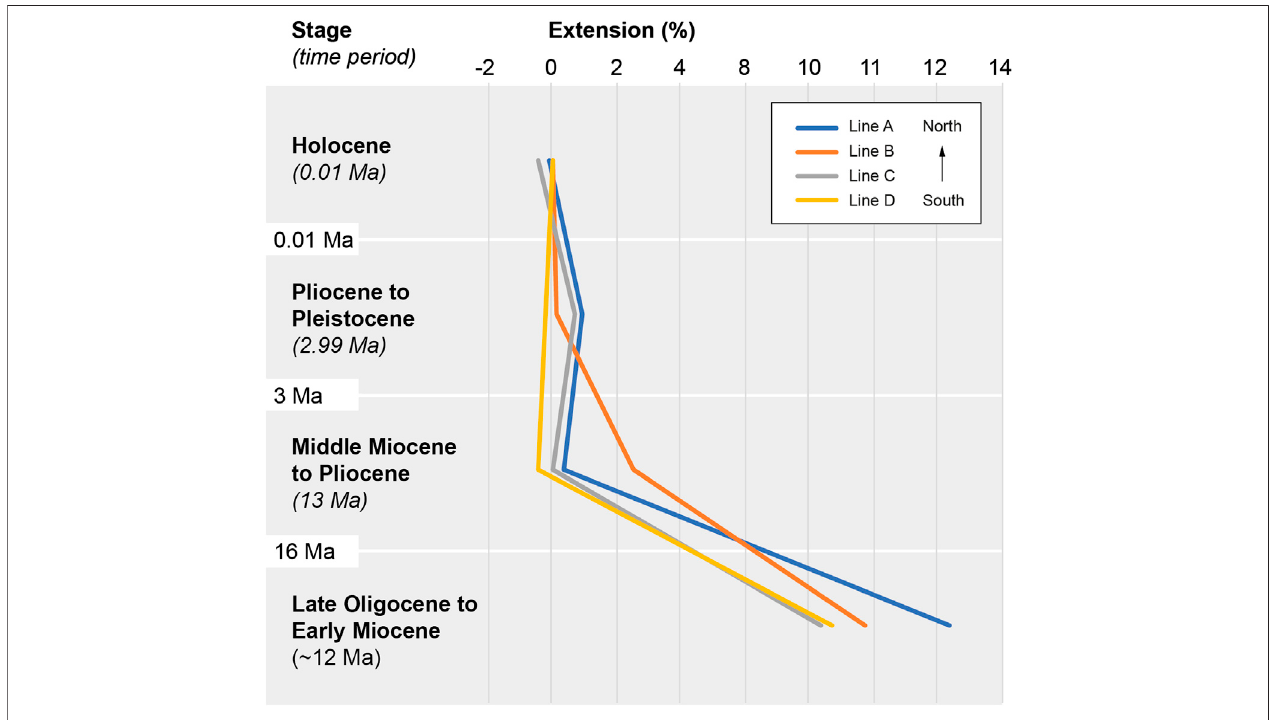
FIGURE 6 | Summary graph showing the amount of extension of Line A to Line